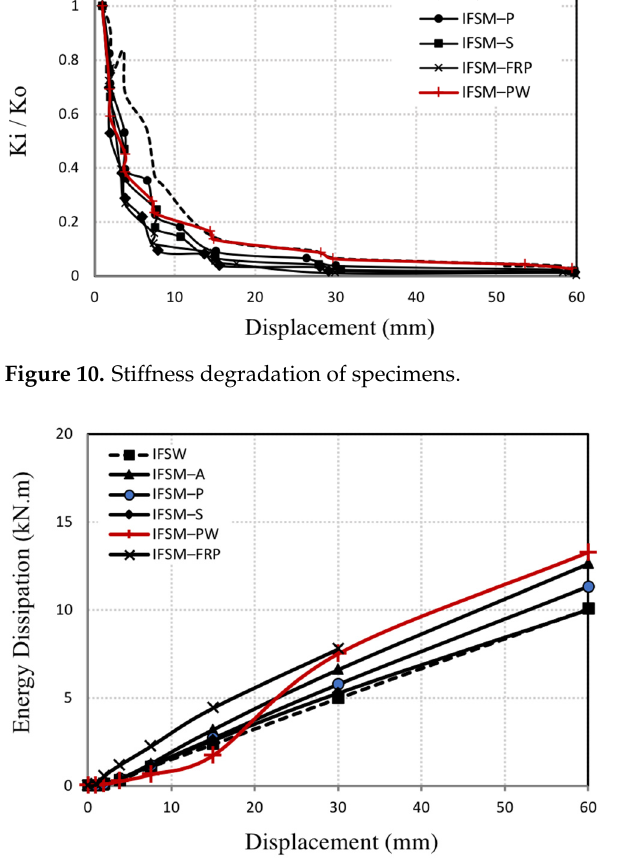
Figure 10. Stiffness degradation of specimens.